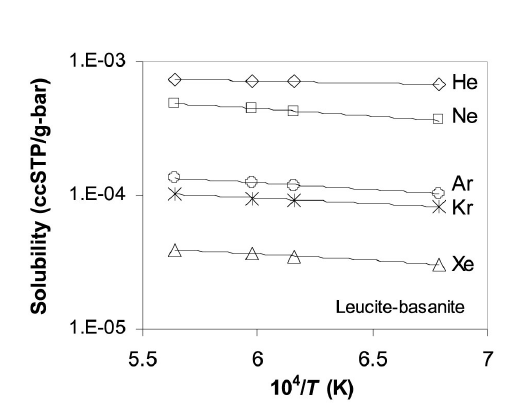
Fig. 10. Temperature effect on noble gas solubility in a basanite melt between 1200 and 1500°C at 0.1 MPa. Data are from Lux (1987) and uncertainties are in the order of the symbol size. Curves were comput- ed by using eq. (3.6) with parameters in table I. Sol- ubility slightly increases with the increase of temper- ature.